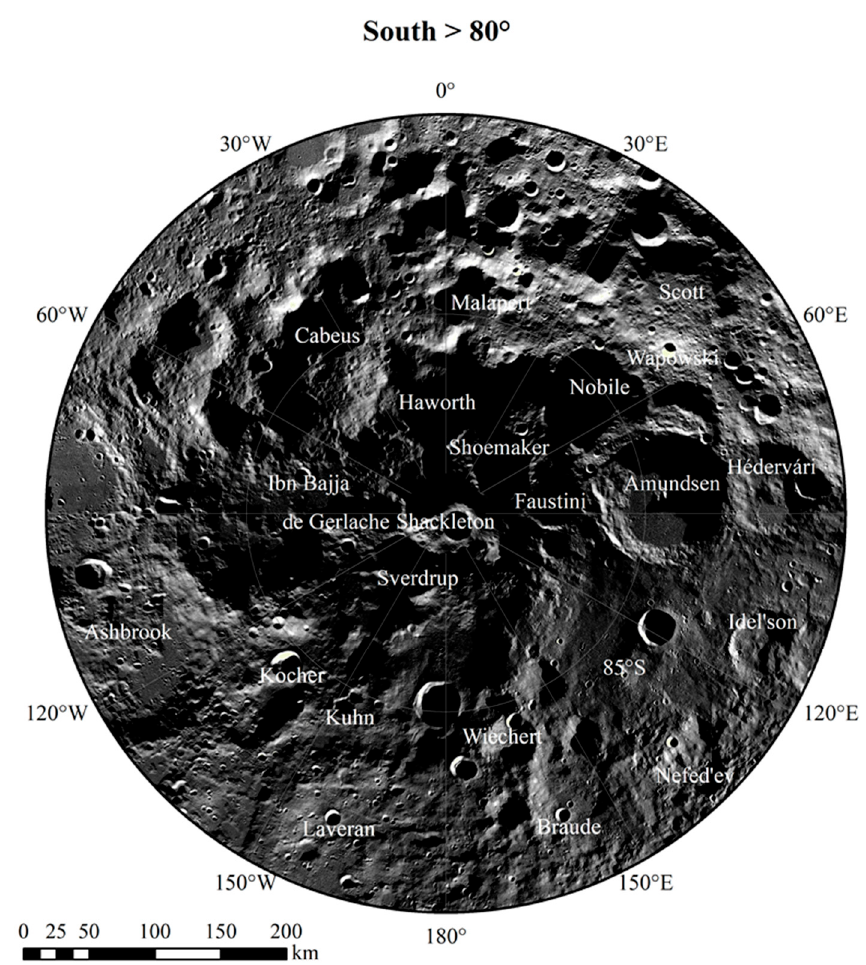
Figure 1. Orthophotogram of the Moon’s south pole (CE-2 DOM 7 m/pix). The perimeter includes the area above 80° south latitude and is projected usinf the polar stereographic projection.